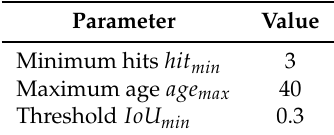
Table 2. SORT parameters for the tracking